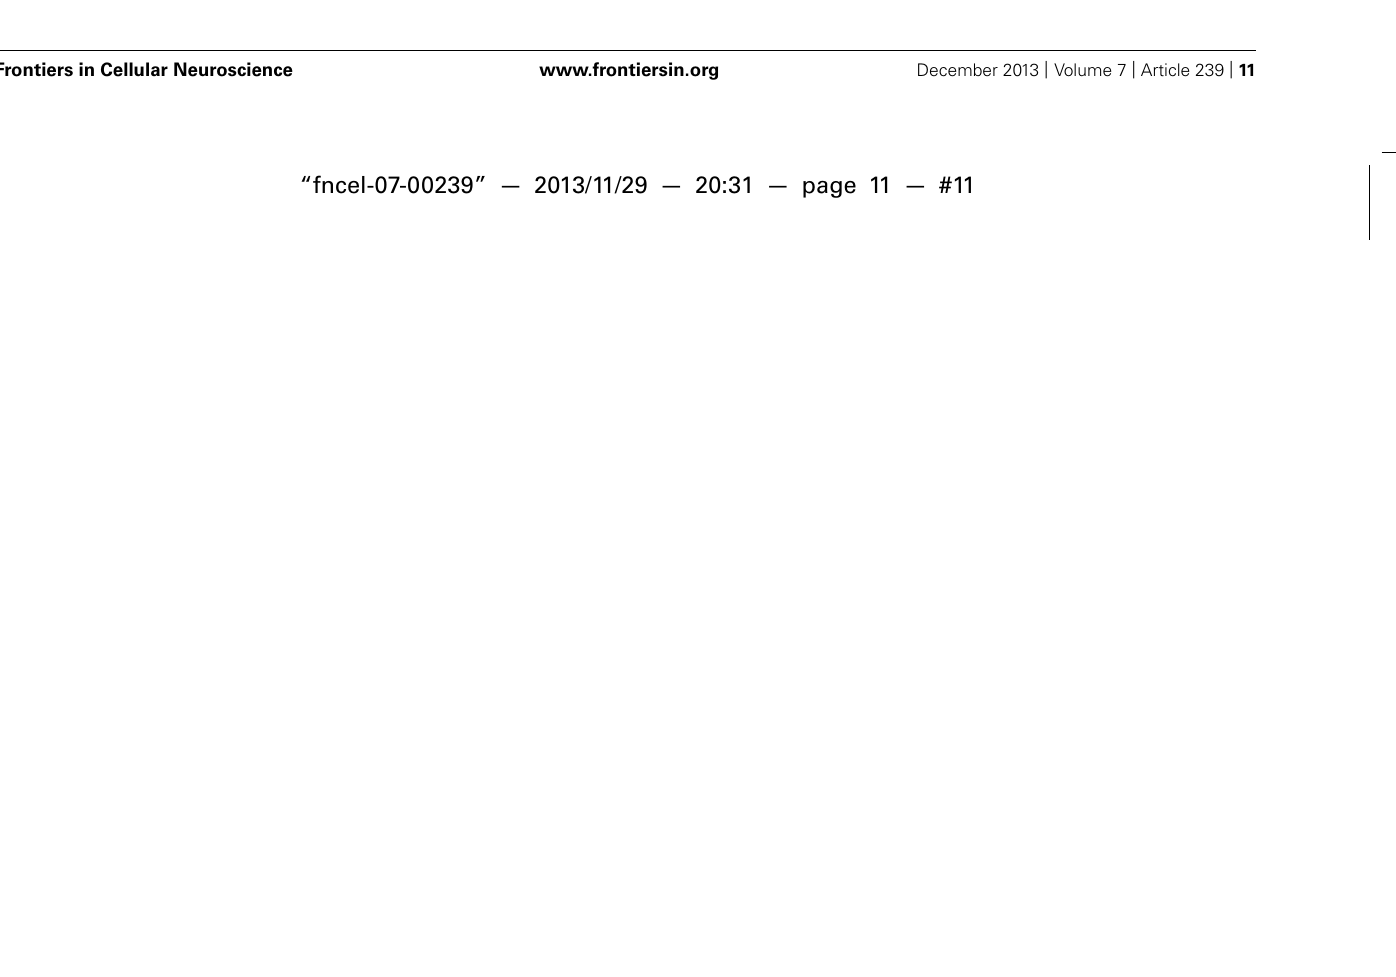
of differentiation. Anti α -tubulin was used as loading control. Data analyses of band intensities are expressed as the mean ± SEM of three independent experiments ( ∗ p < 0.05; ∗∗∗ p < 0.01). (D) NSC-34 cells were transfected with an Id1 promoter luciferase (Luc) reporter gene. Enzyme activity was measured before or after 24 and 36 h of differentiation and normalized by Renilla (Ren) luciferase activity. Data are the mean ± SD of three independent experiments performed in quadruplicate ( ∗ p <